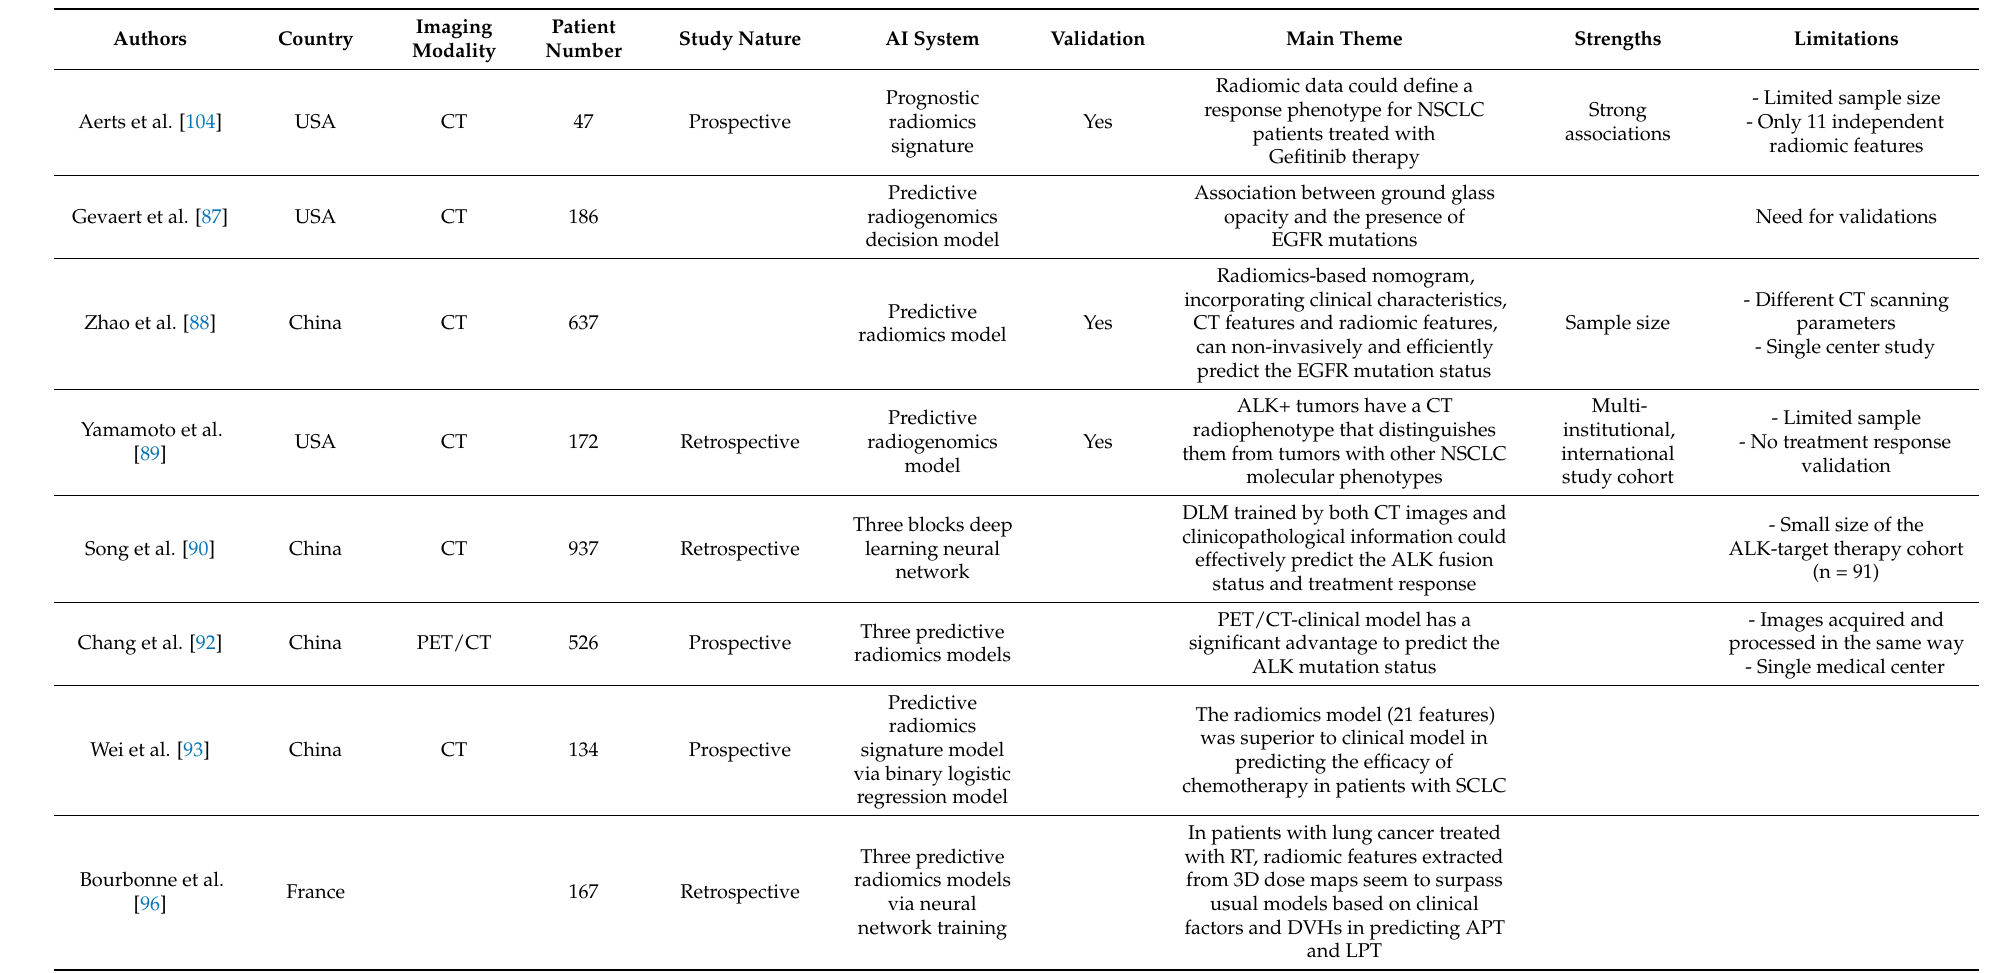
Table 3. Characteristics of different studies on the use of AI in outcome prediction and response to treatment, including strengths and